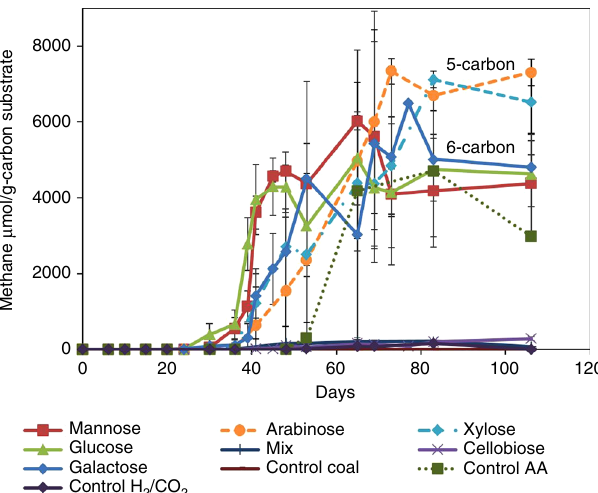
Fig. 2 Pro fi le of methane yeilds in all microcosms. The highest yeilds were from galactose, mannose, glucose, xylose, arabinose, and acetic acid-fed systems. The lowest yeilds were from the mix, cellobiose, H 2 /CO 2 , and controls with only coal. Data points represent the means ± s.d., n = 3 per group